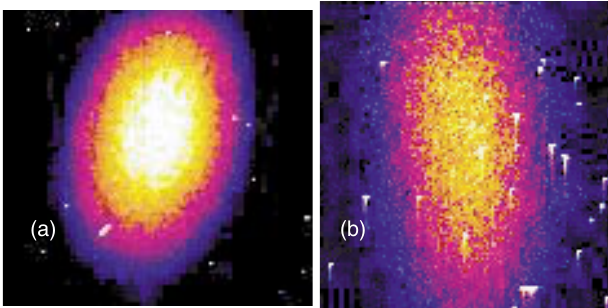
FIG. 32. (Color) Single shot, false-color x-ray beam images measured by the CCD for the (a) uncompressed and (b) compressed electron beams. The color scale has yellow as most intense, with violet as lowest non-negligible intensity